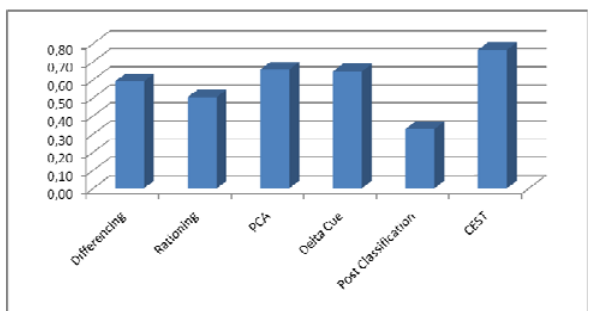
Tab. 1  -coefficients for the change detection methods